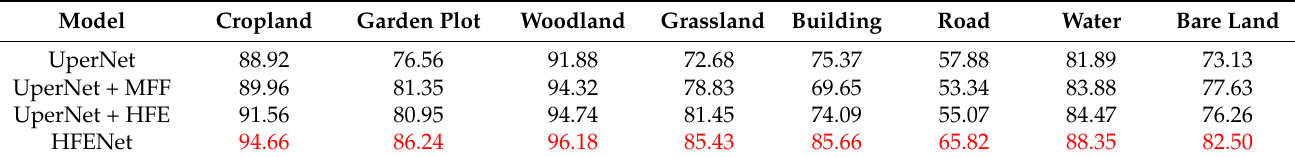
Table 3. The IoU values for each category of HFE and MFF ablation experiments on the MZData (%).